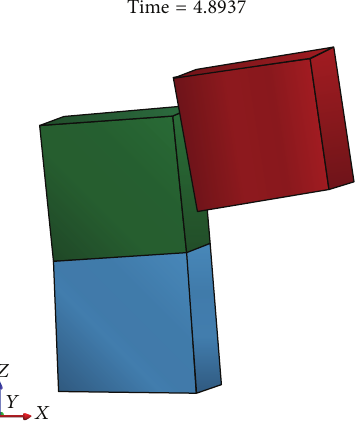
Figure 3: Block impact under full contact conditions (4.8 sec).